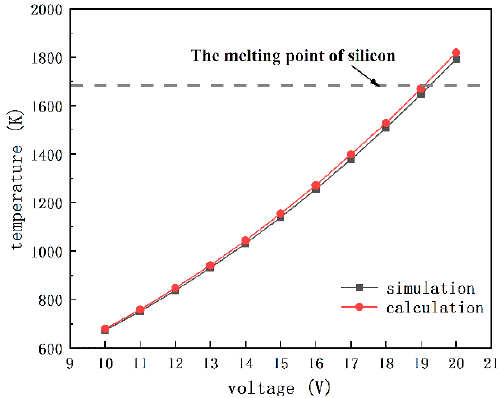
Figure 11. The profile of maximum temperature on the V-shape beam.